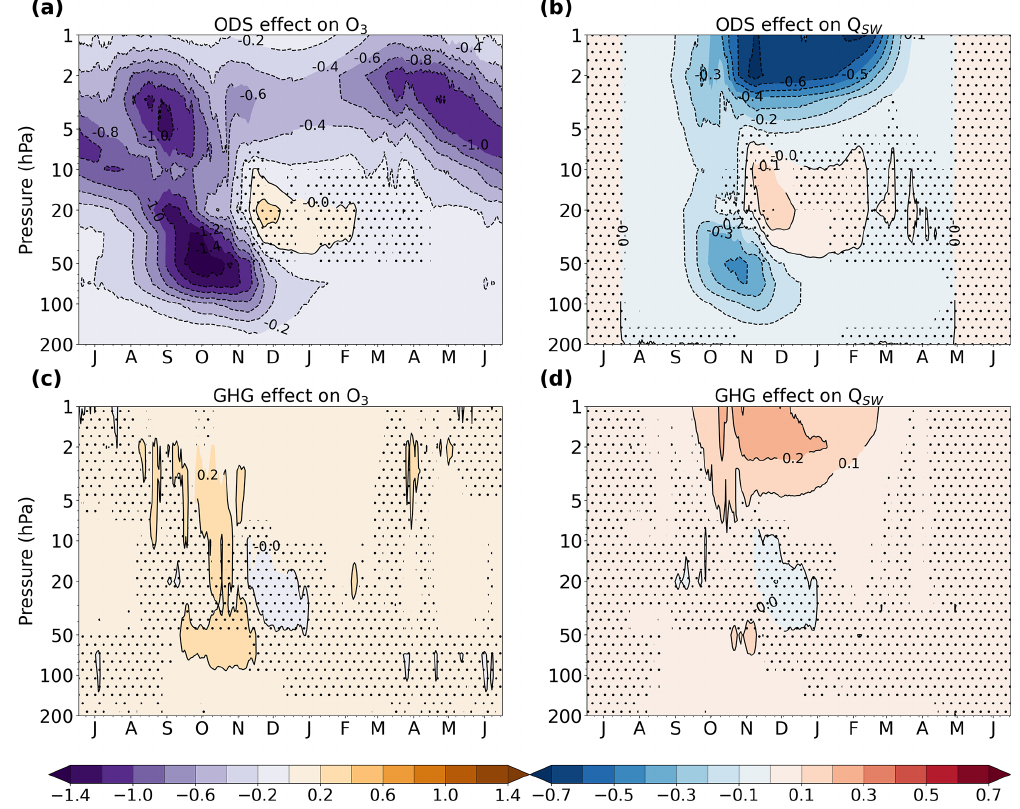
Figure 1. Seasonal cycle of the difference between REF and NoODS (a, b) and between REF and NoGHG (c, d) in the ozone volume mixing ratio ( a, c ; ppmv) and the SW heating rate ( b, d ; Kd − 1 ) averaged over the polar cap (70–90 ◦ S) for the period 1978–2002. Stippling masks values that are not significant at the 95% confidence interval. The letter corresponding to each month marks the middle of that